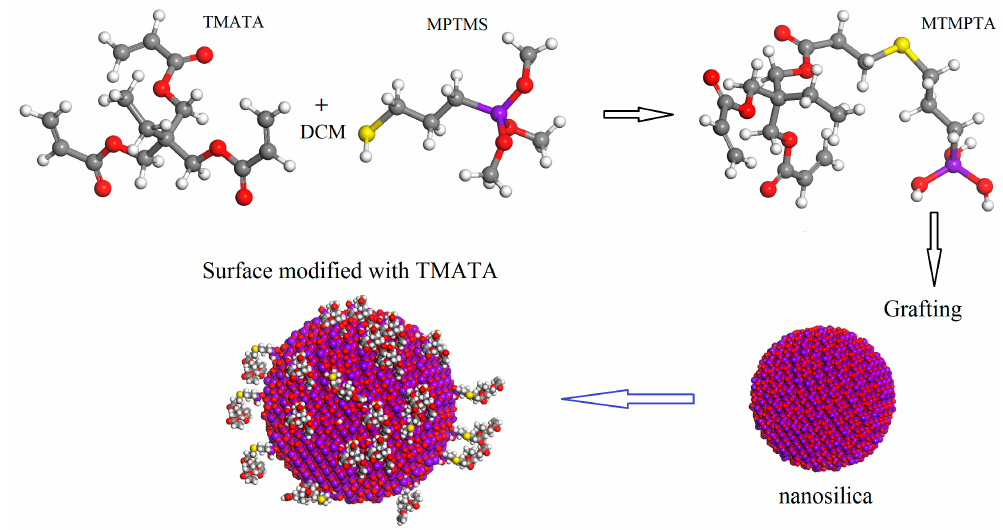
Figure 1. Schematic reactions of TMATA grafting onto nanosilica surface. Table 2. Blending components (wt%) of raw materials for preparing XLPE and its nanocomposites. Materials LLDPE BPL TMPTA